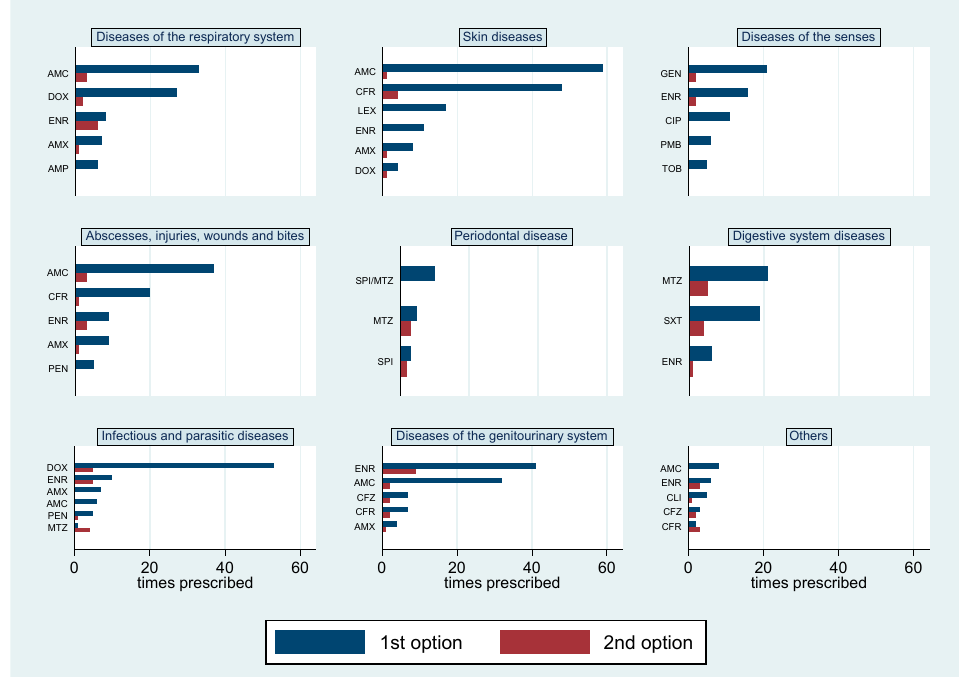
Figure 3. Antibiotics prescribed as first and second treatment options for different diseases reported by respondents ( n = 853). AMC, amoxicillin + clavulanic acid; DOX, doxycycline; ENR, enrofloxacin; AMX, amoxicillin; AMP, ampicillin; CFR, cefadroxil; LEX, cephalexin; GEN, gentamicin; CIP, ciprofloxacin; PMB, polymyxin B; TOB, tobramycin; PEN, penicillin; SPI/MTZ, spiramycin + metronidazole; MTZ, metronidazole; SPI, spiramycin; SXT, sulfamethoxazole + trimethoprim; CFZ, cefazolin; CLI, clindamycin.